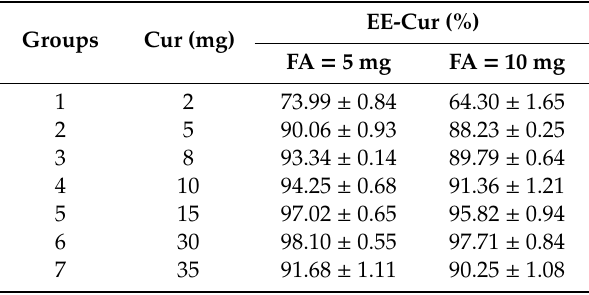
Table 2. E ff ect of Cur dosage on the EE-Cur of FA-AmCS-TPP nanoparticles.